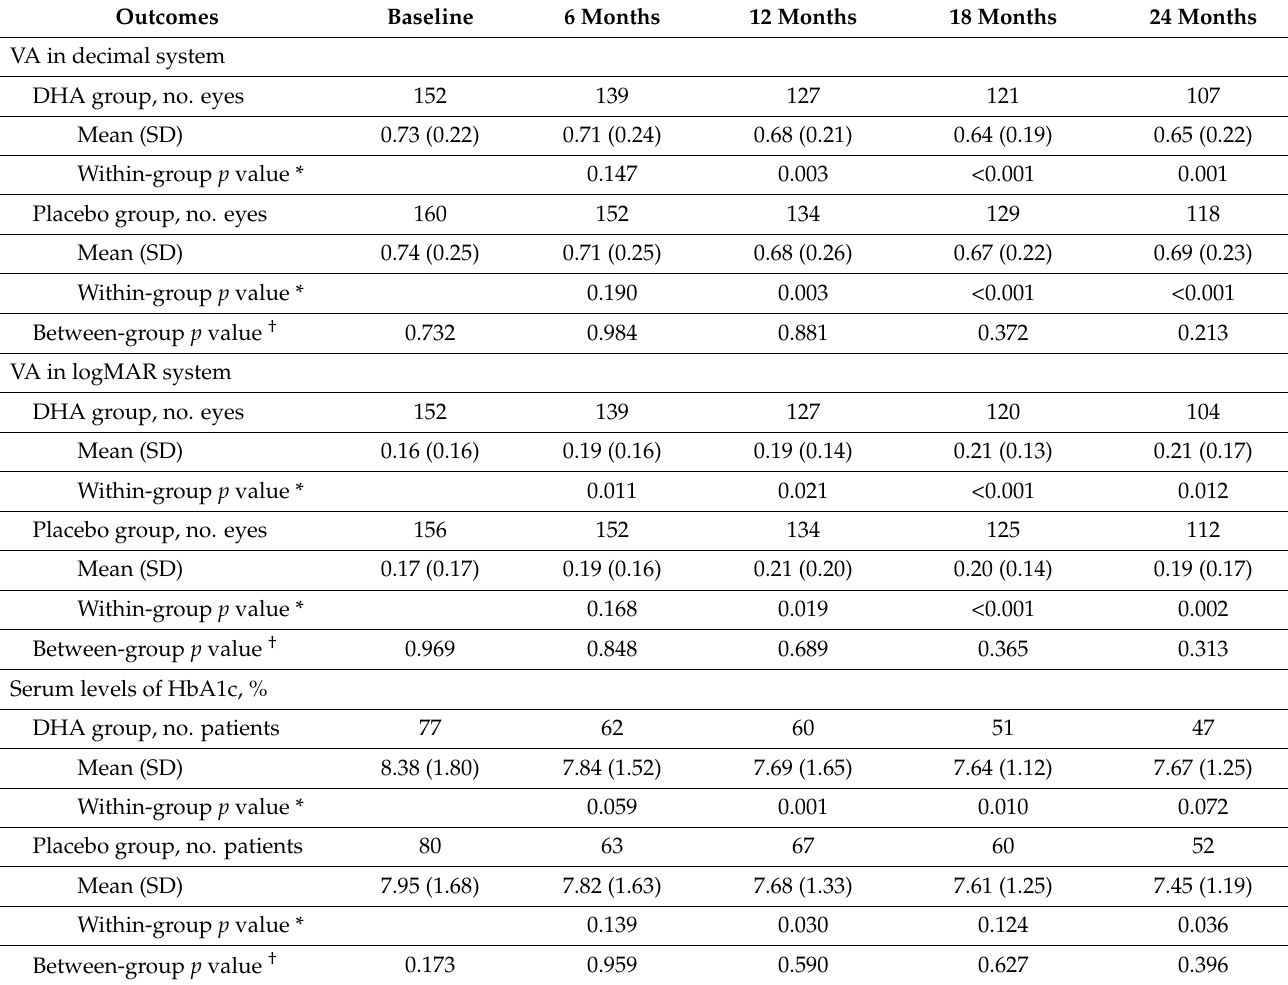
Table 5. Results of secondary outcome variables: visual acuity (VA) and serum levels of HbA1c in the two study